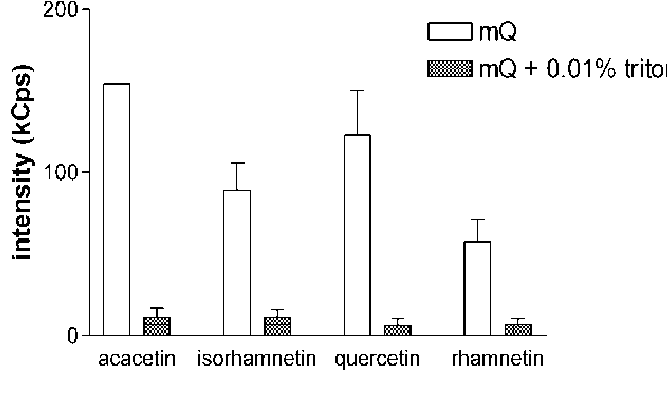
Figure 2. Addition of non-ionic detergent eliminates the DLS signal of flavonoids. Scattering intensities of acacetin, isorhamnetin, quercetin and rhamnetin, selected as representative examples, in pure mQ water and in mQ water with 0.01% Triton X-100. Sample concentration was 10 µM in all measurements. Results represent mean and SD